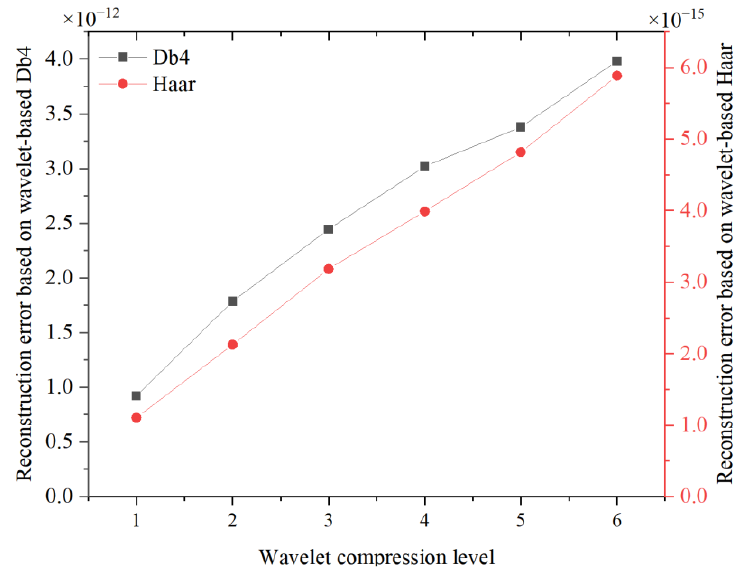
Figure 11. Gas data reconstruction